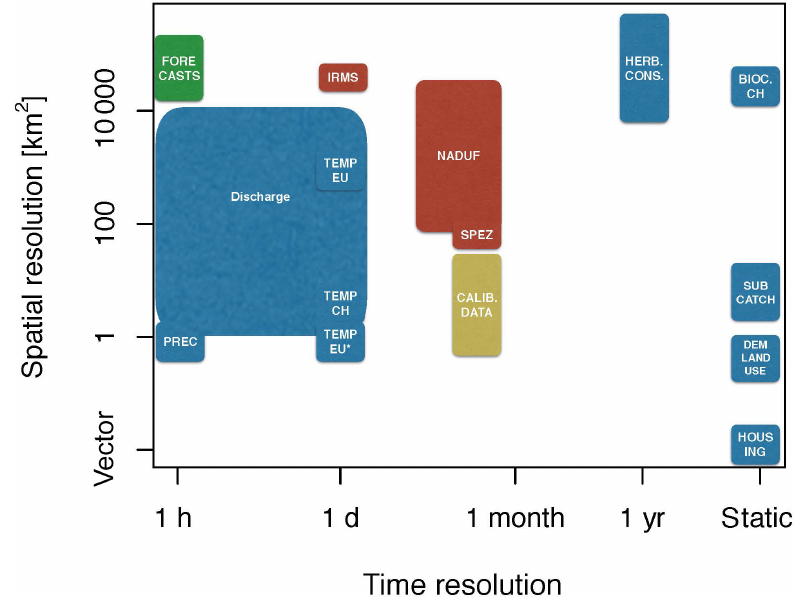
Figure 7. Spatial and temporal resolution of input variables (blue), calibration data (yellow), validation data (red) and forecasts (green). Abbreviations: prec: precipitation, temp: temperature, herb: herbicide, cons: consumption, bioc: biocides, catch: